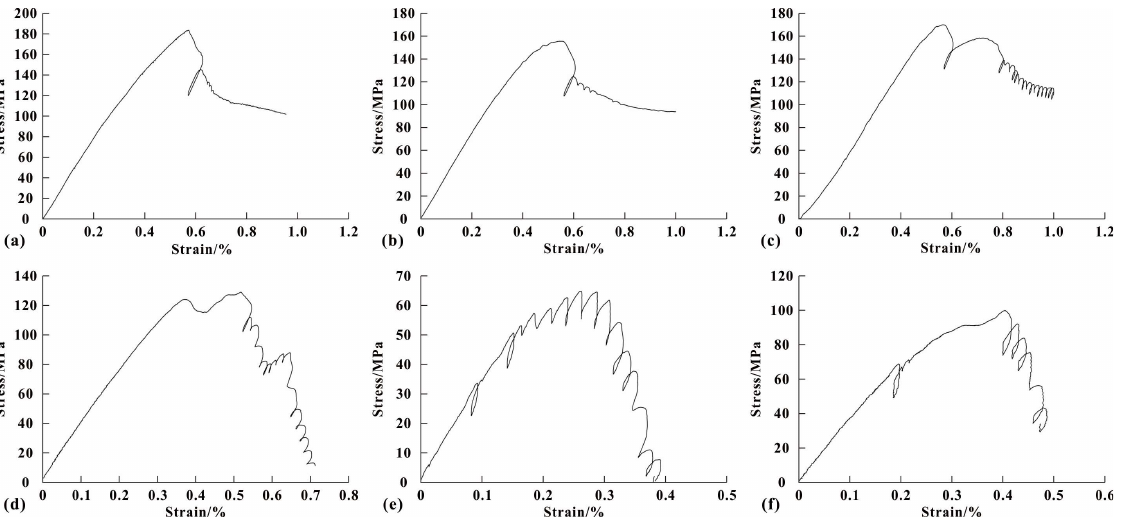
Figure 14. Stress–strain curves with different shell content. ( a – c ) Low shell content. ( d – f ) High shell content.